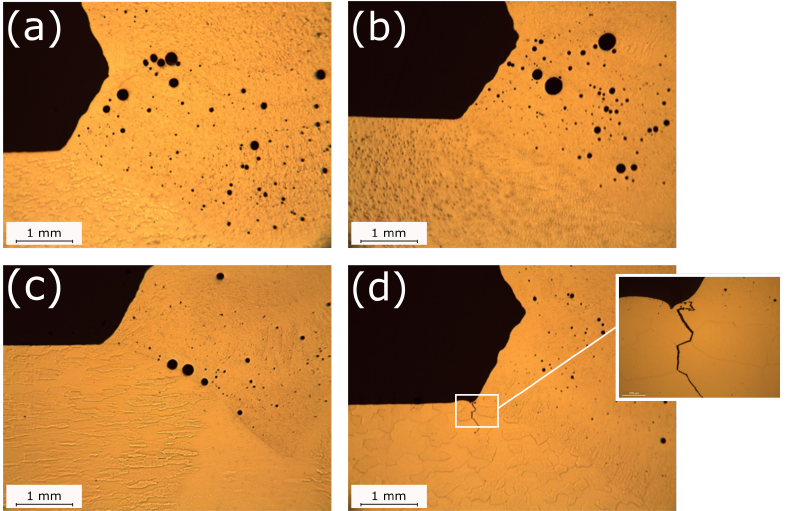
Figure 4. Optical image of cross sections focused on the FZ/PMZ boundary in the ( a ) 2219, ( b ) 2024, ( c ) 2050 and ( d ) 2139